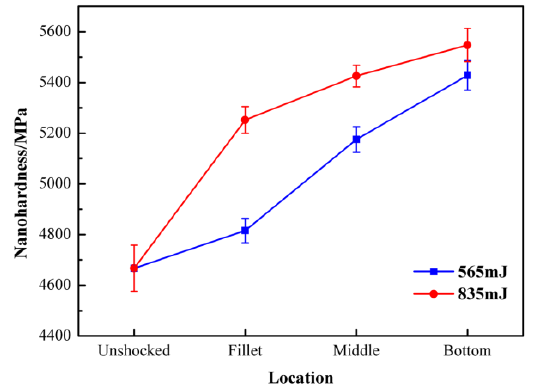
Figure 13. The nanoindentation load-displacement curve of 304 stainless steel foil with 40 µm before and after laser flexible shock.